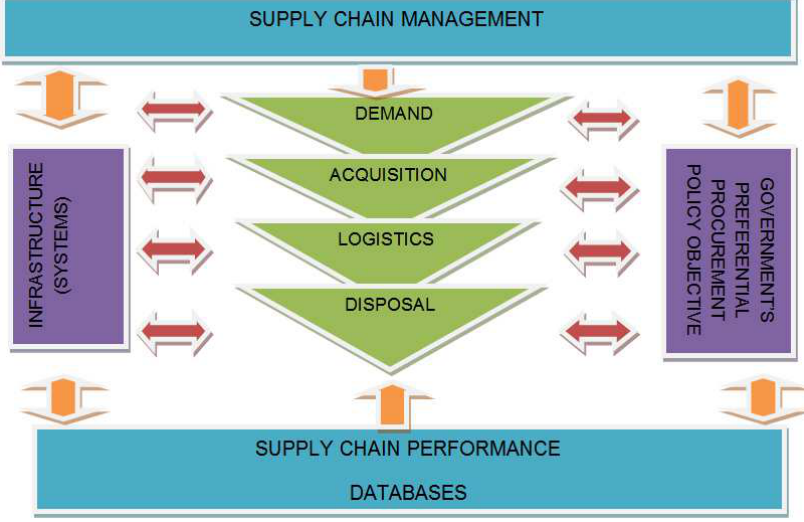
Fig. 1. Supply chain management business